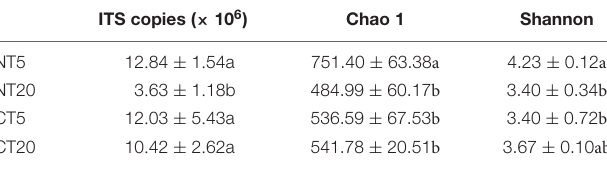
TABLE 1 | Soil fungal gene abundance and diversity indices at different soil depths under NT and